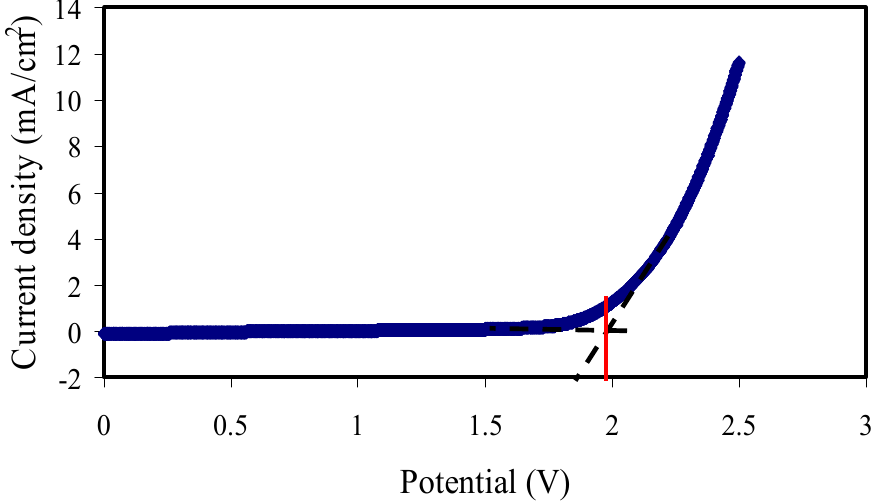
Figure 9. LSV for the highest plasticized sample (PSP_2) at RT.